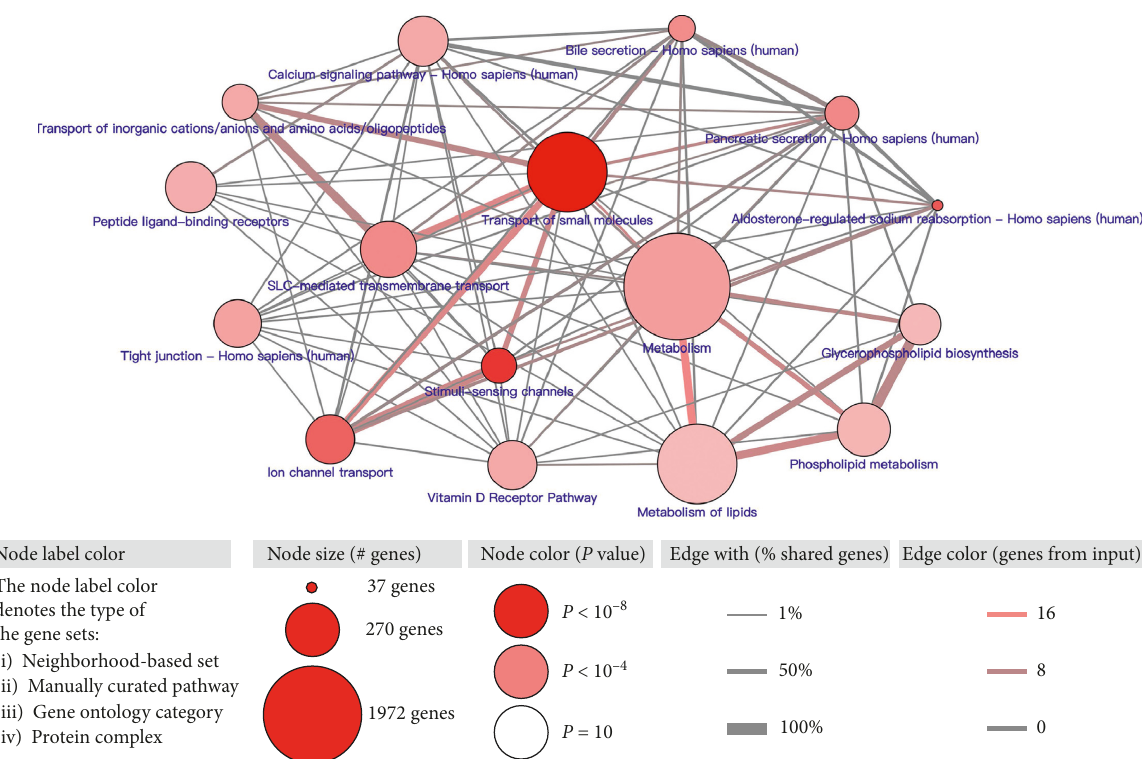
Figure 5: Pathway enrichment analysis for GUCA2A coexpressed